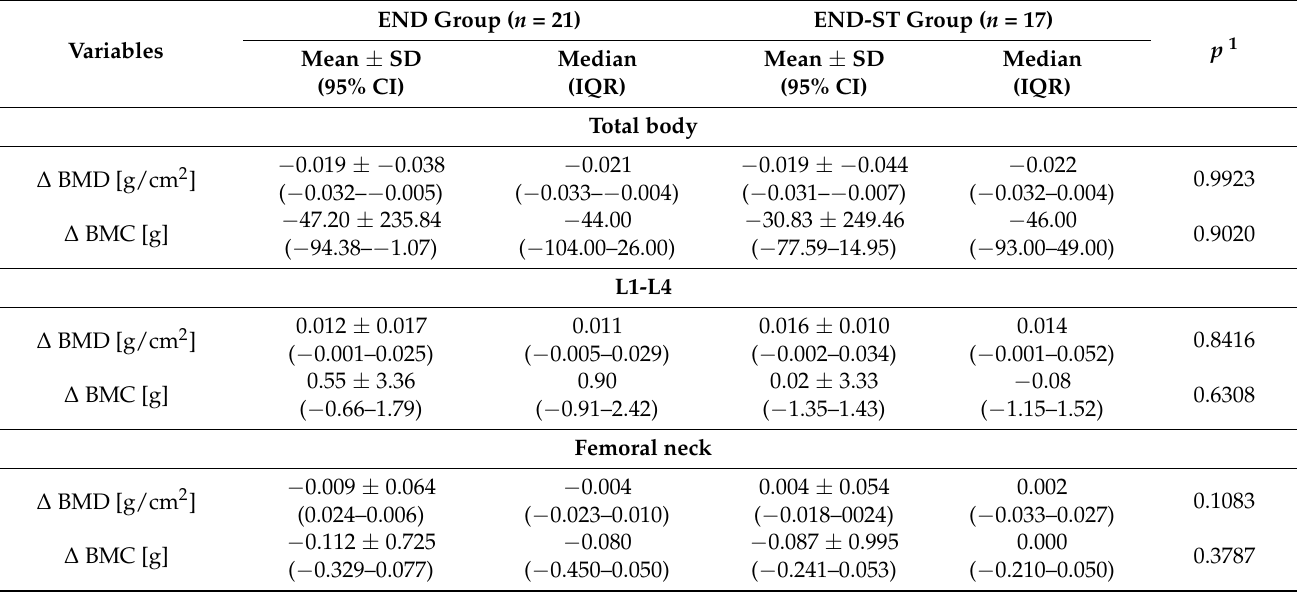
Table 6. Comparison of the differences ( ∆ ) in the effect of endurance and endurance-strength training on bone parameters.